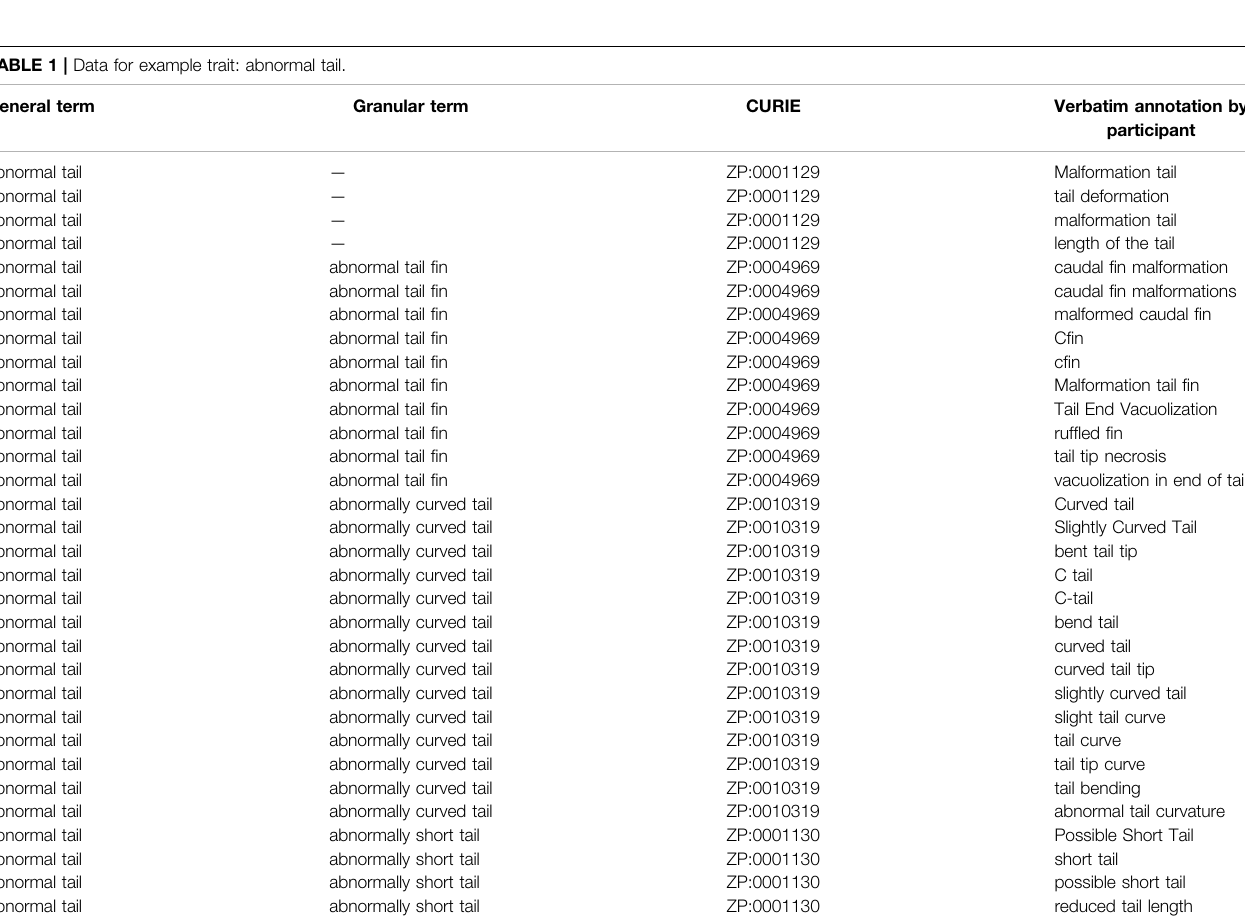
TABLE 1 | Data for example trait: abnormal